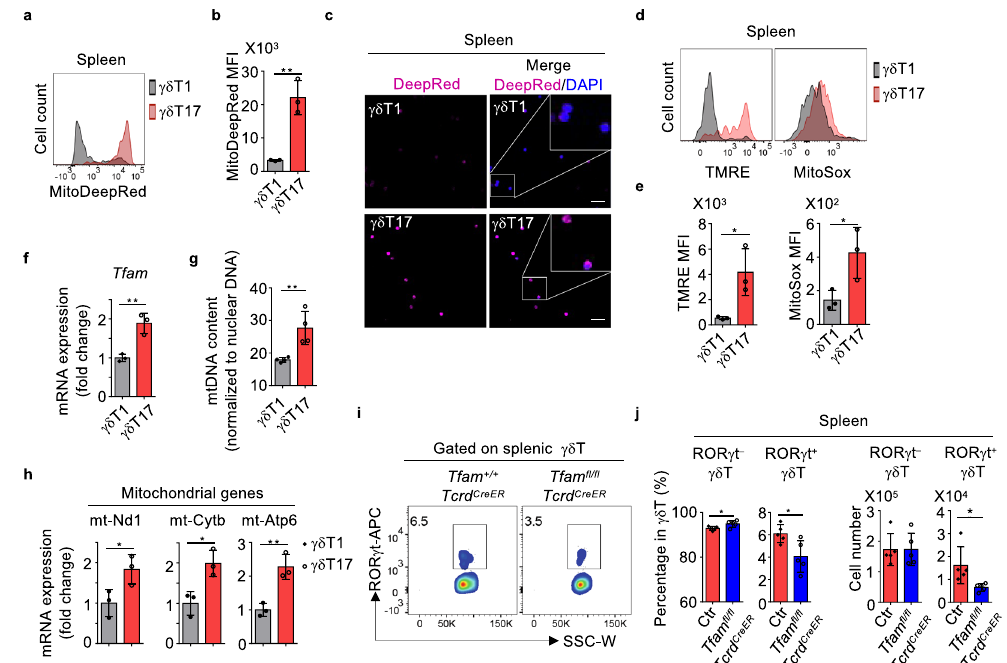
Fig. 1 Tfam de fi ciency affects γδ T1 and γδ T17 cells differentially. a MitoTracker-Deep Red staining in splenic γδ T1 and γδ T17 cells by fl ow cytometry. Representative data of three independent experiments. b MitoTracker-Deep Red mean fl uorescence intensity (MFI) in a ( n = 3 for each group) (** P = 0.0032). Compiled data from one experiment. c Confocal analysis of MitoTracker-Deep Red staining in splenic γδ T1 and γδ T17 cells. Scale bar, 50 µ m. Representative data of two independent experiments. d Tetramethylrhodamine, ethyl ester (TMRE) and MitoSox TM Red staining in splenic γδ T1 and γδ T17 cells by fl ow cytometry. Representative data of three independent experiments. e TMRE (* P = 0.0281) and MitoSox TM MFI (* P = 0.0404) in d ( n = 3 for each group). Compiled data from one experiment. f Expression of Tfam measured by quantitative real-time PCR (qRT-PCR) in the splenic γδ T1 and γδ